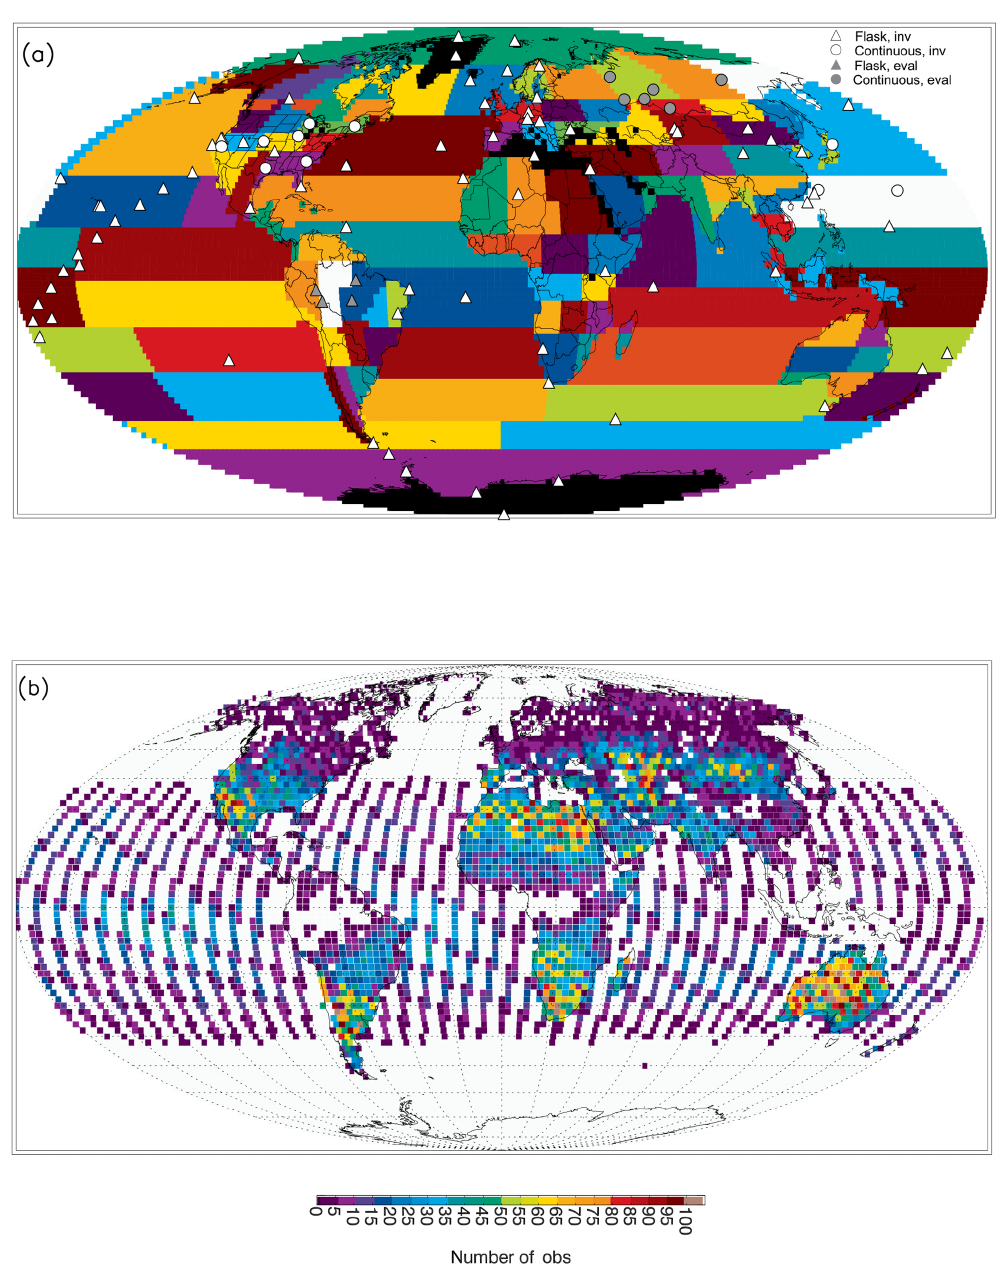
Figure 1. Locations of (a) in situ observation sites and (b) GOSAT X CO 2 observations used in the inversions. Also shown in (a) are the 108 flux regions. Flask and continuous measurement sites in (a) are represented by different symbols, and sites used in inversions and in their evaluation are represented by different colors. Observations in (b) correspond to the ACOS B3.4 retrieval, are filtered and averaged over each hour and 2 ◦ × 2.5 ◦ PCTM model grid column, and are shown for June 2009–May